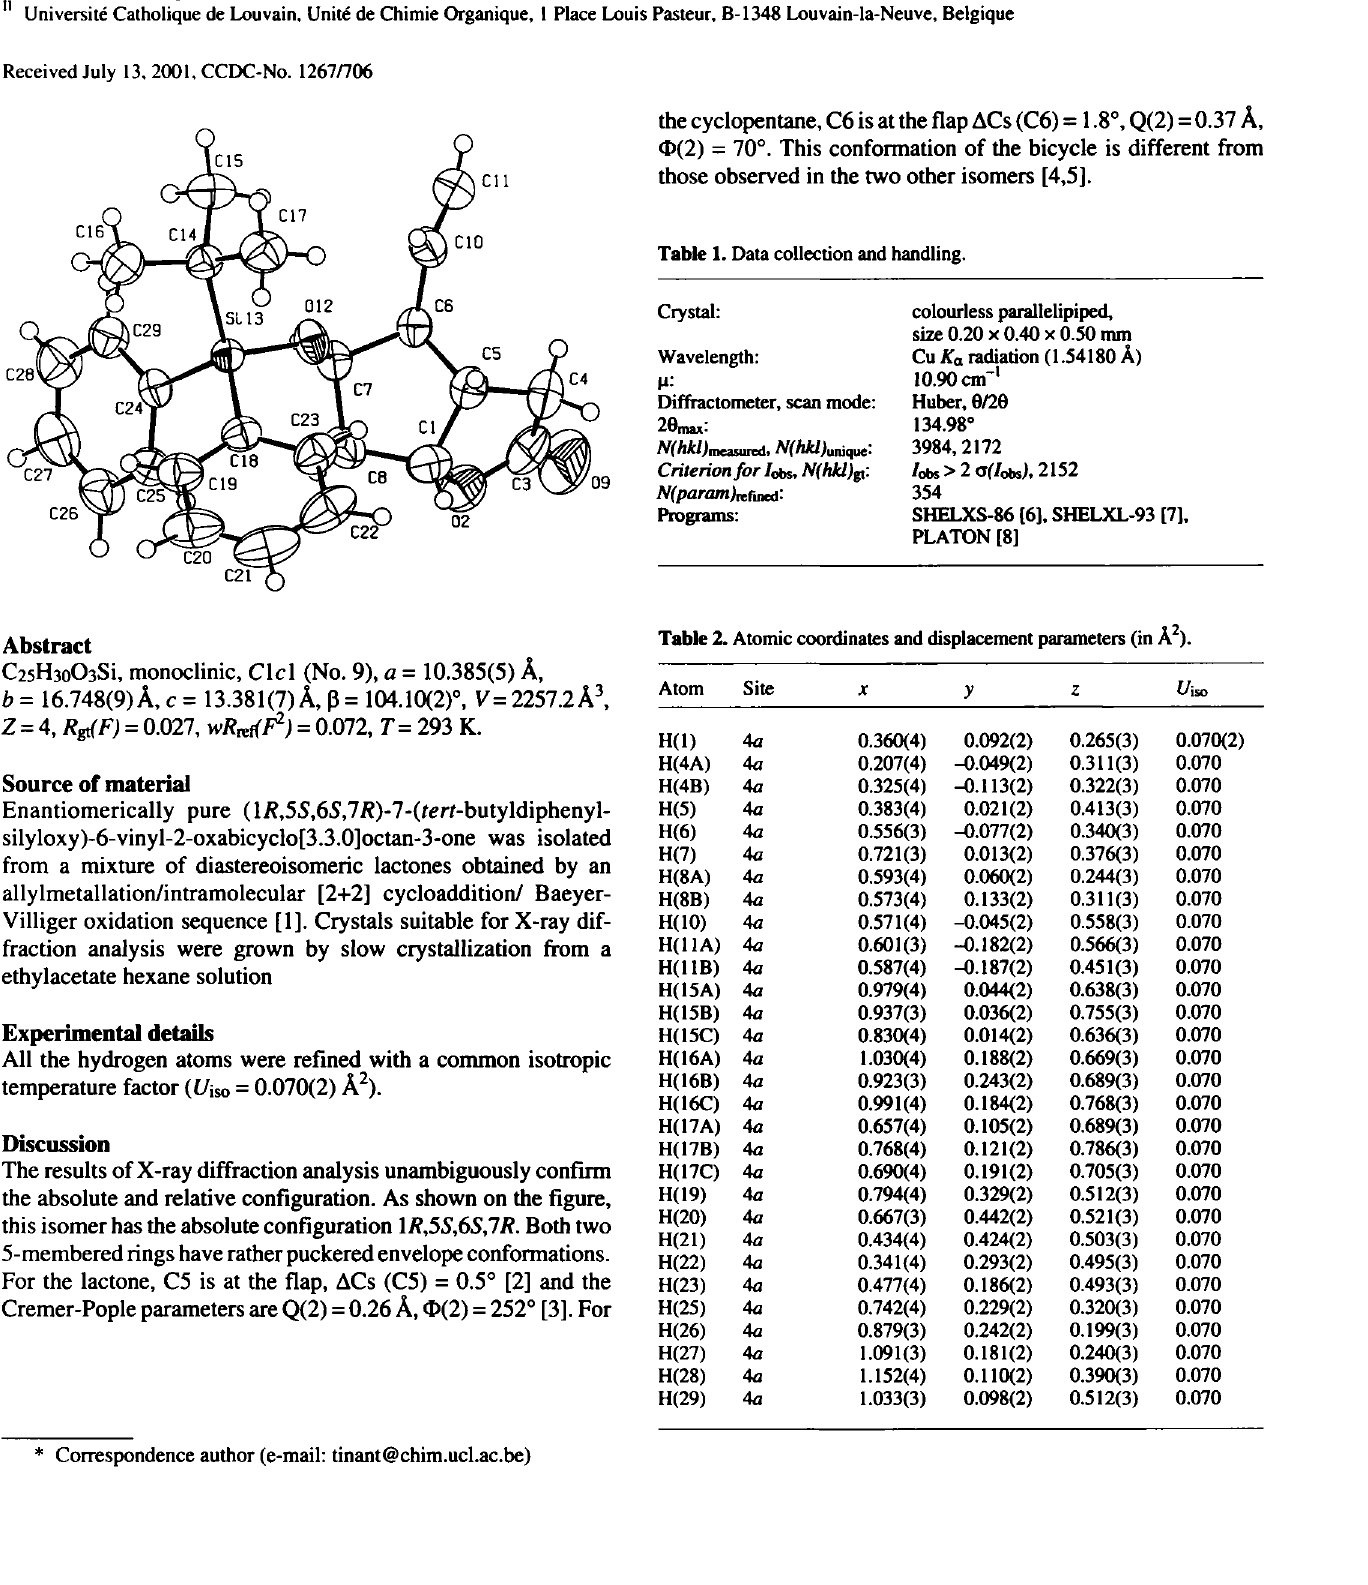
Table 1. Data collection and handling.